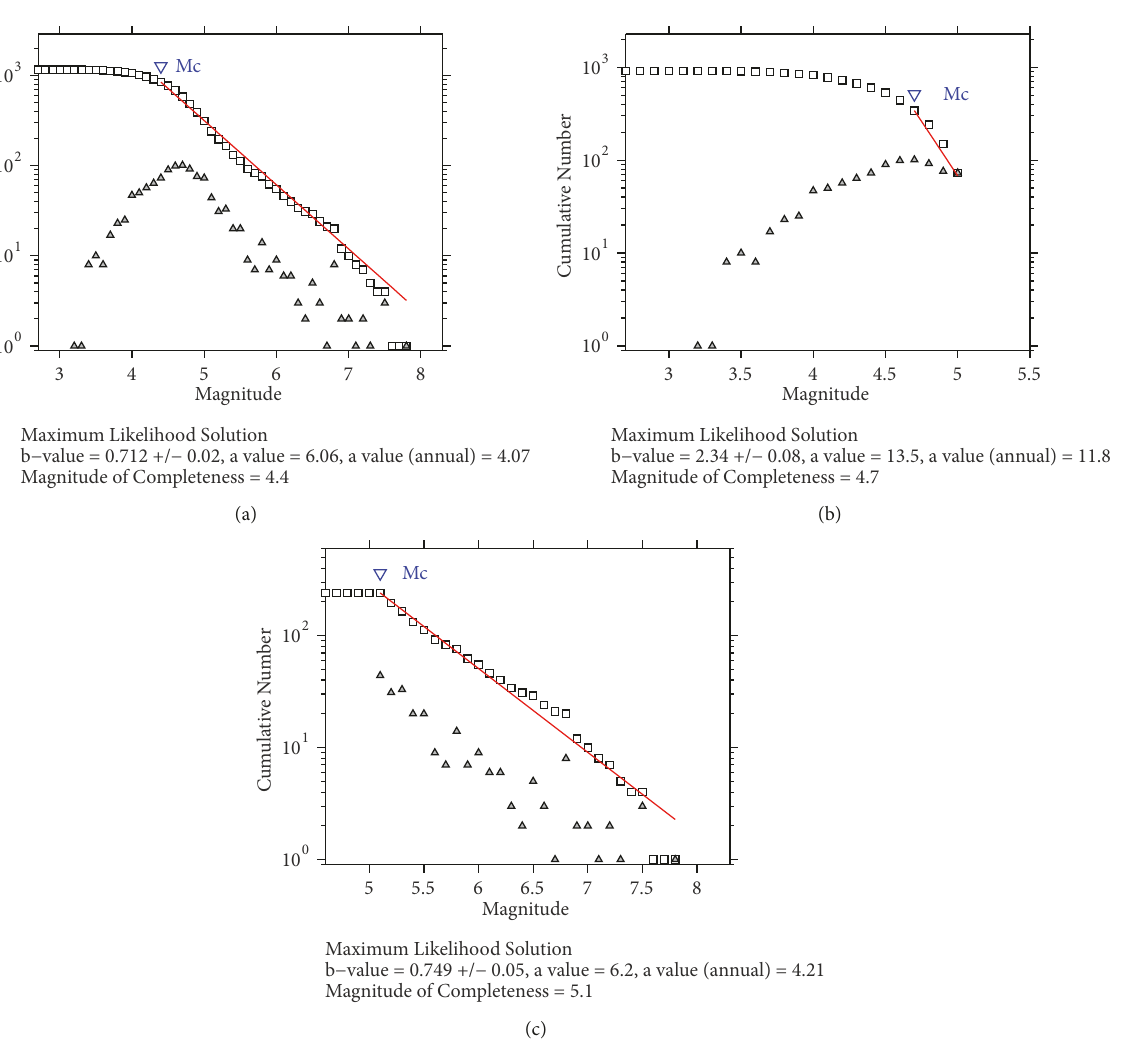
Figure 11: Magnitude distribution graph of seismicity for cluster 2 (Timor island, Alor island, and surrounding areas): (a) for mb > 3 SR, (b) for mb= 3-5 SR, and (c) for mb > 5